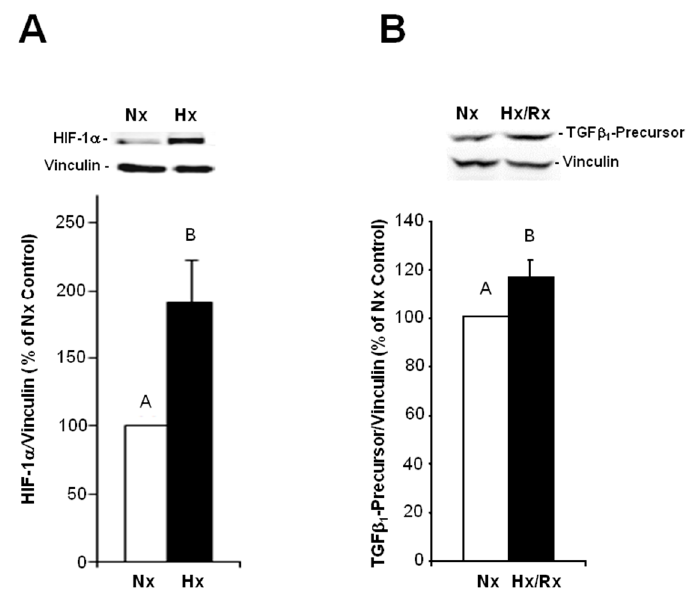
Figure 2. Induction of hypoxia inducible factor 1 α (HIF-1 α ) and TGF β 1 by hypoxia. MVECs were cultured under hypoxic conditions (Hx) in an atmosphere containing 95% N 2 /5% CO 2 and then reoxygenated (Rx). Total proteins were extracted ( A ) after one hour hypoxia for detection of HIF-1 α , and ( B ) after one hour hypoxia and 15 min of reoxygenation for detection of TGF β 1 . Western blots were performed using antibodies against HIF-1 α , TGF β 1 or vinculin as loading control. Representative Western blots, and quantification of HIF-1 α expression are depicted. ( A ) HIF-1 α /vinculin ratios are expressed as percent increase relative to normoxic controls, and are presented as means ± SE of n = 5–7 independent culture preparations; ( B ) TGF β 1 /vinculin ratios are expressed as percent increase relative to normoxic controls, and are presented as means ± SE of n = 4 independent culture preparations. Uppercase letters indicate significant differences between groups with p ≤ 0.05.